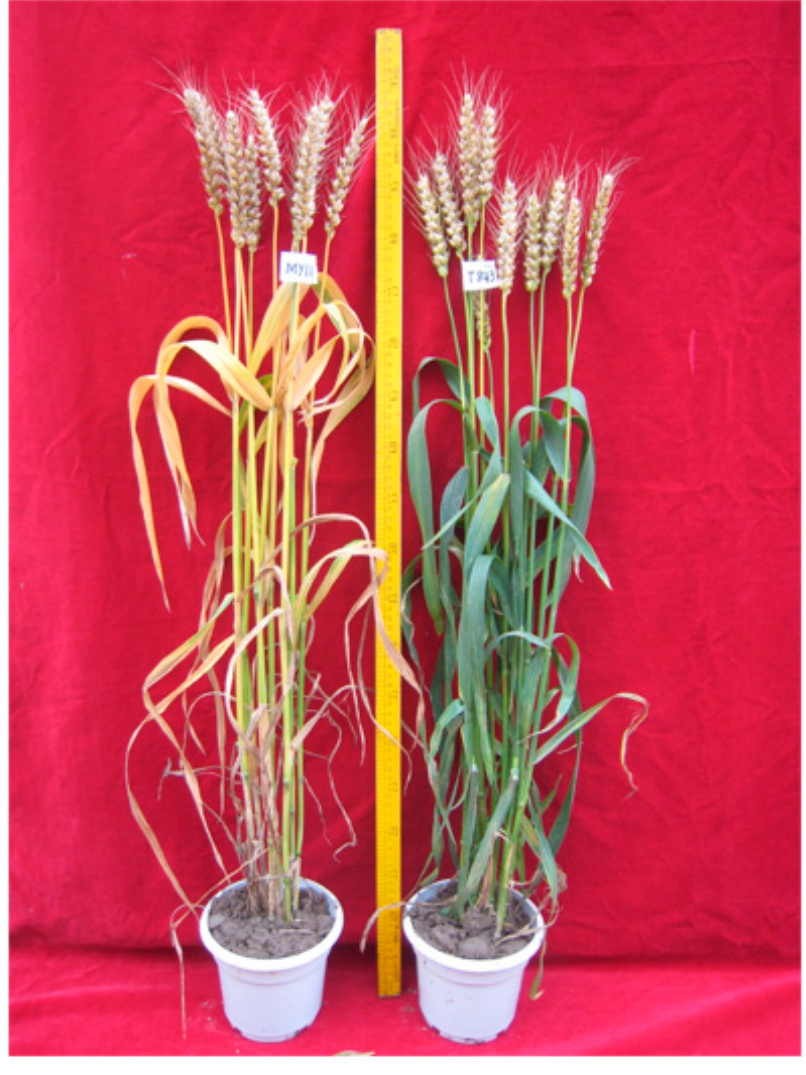
Figure 4. RT843-5 exhibited stay-green traits during the filling period. Left: wheat parent, nonstay- green line MY11. Right: RT843-5.